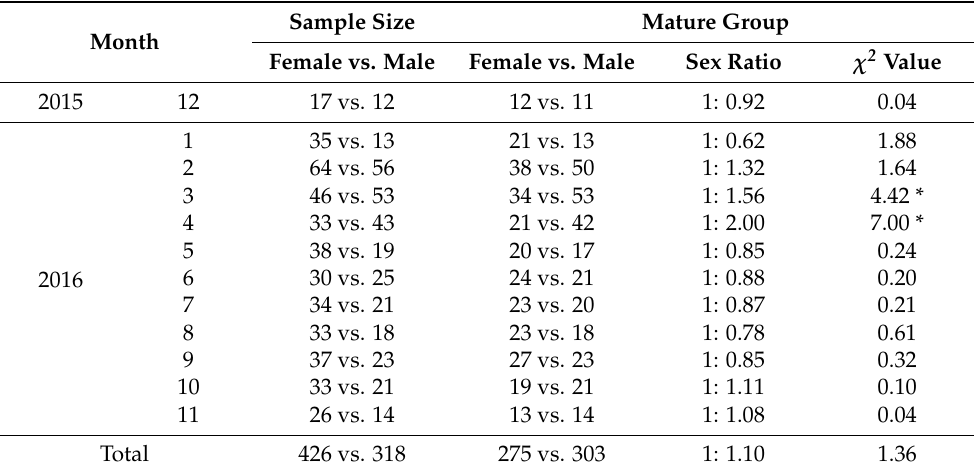
Table 1. Sample size and the monthly sex ratio of the mature group of G. tibetana in the lower Yarlung Tsangpo River from December 2015 to November